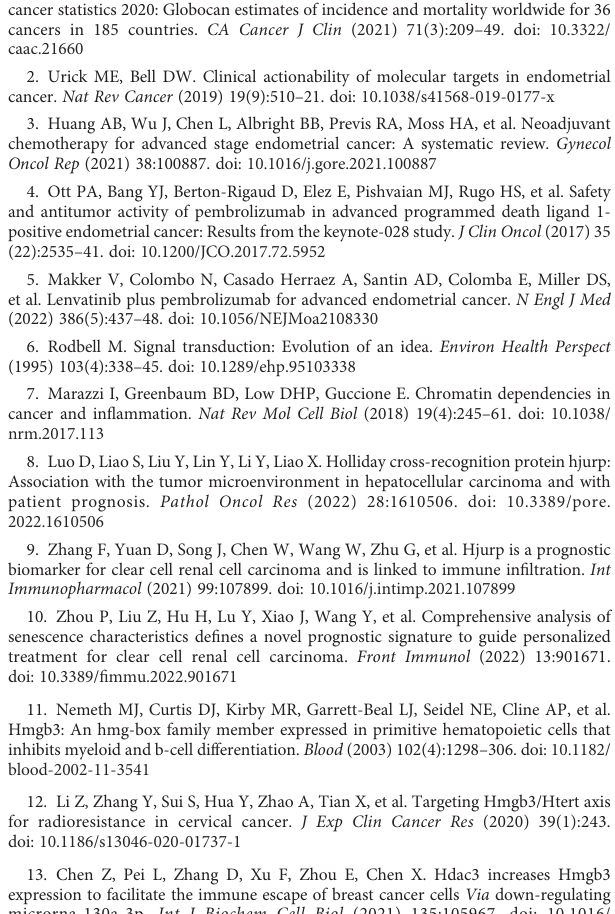
SUPPLEMENTARY FIGURE 6 The biological characteristics of different risk groups. (A) . GSEA analysis of biological process gene sets from the GO dataset. (B) . GSEA analysis of molecular function gene sets from the GO dataset. SUPPLEMENTARY FIGURE 7 Relationships between CRRS and the Tumor Microenvironment. (A) . Relative cell abundance of CD8 + T cells, macrophages, DC cells, and NK cells were calculated by different algorithms in the low- and high-CRRS groups. SUPPLEMENTARY FIGURE 8 APOBEC3G was positively correlated with CD8 + T cells in UCEC. (A) . Multivariate analysis con fi rmed the correlation between the 9 TME- associated CRs and the levels of in fi ltration of CD8 + T cells. (B) Kaplan – Meier curve for OS between high- and low- APOBEC3G groups. (C) Correlation between the APOBEC3G and CD8 + T effector signature in TCGA-UCEC. (D) Validation of the correlation between APOBEC3G and CD8/GZMB by qRT-PCR. (E) The results of APOBEC3G, CD8, GZMB expression distribution in single cell dataset (UCEC-GSE139555). SUPPLEMENTARY FIGURE 9 CRRS and Tumor Microenvironment associations in the TCGA pan-cancer dataset. (A) . The correlation between the CRRS and immune score, stromal score, ESTIMATE score, and tumor purity. (B) . Heatmap illustrating the correlation between the CRRS and immune checkpoints, immune cells, and tumor microenvironment-related